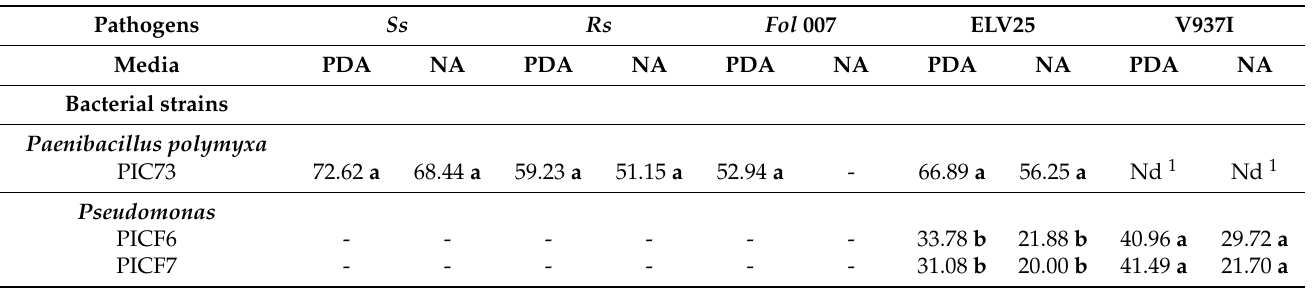
Table 1. Percentage of growth inhibition exerted over different fungal pathogens by Pseudomonas sp. PICF6 and Pseudomonas simiae